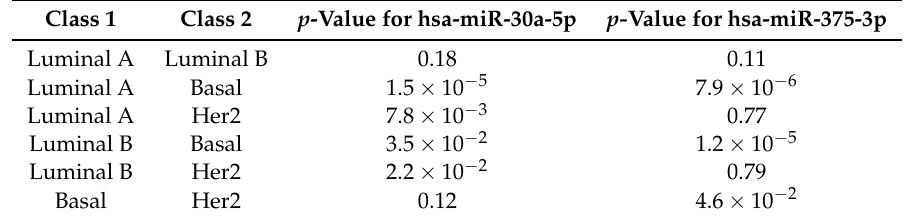
Table 1. Results of the Mann–Whitney U-test applied to expressions of miRNAs in The Cancer Genome Atlas (TCGA) miRNA-seq data.